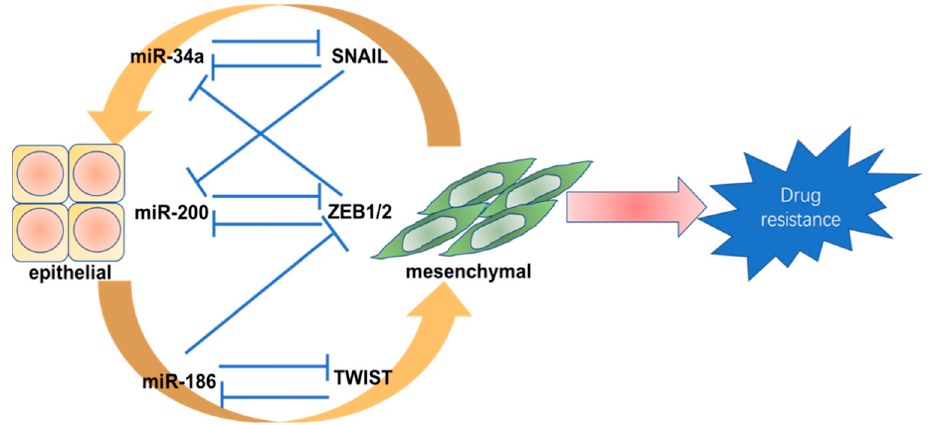
Figure 2. The relationship between miRNAs and epithelial–mesenchymal transition-inducing transcription factors (EMT-TFs).